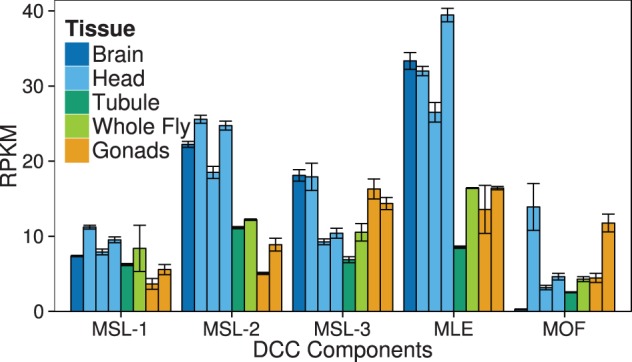
Expression level of DCC components in RNA-seq data sets. Expression level was measured in terms of RPKM. The data are from data sets 1, 2, 3, 4, 7, 8, 12, and 13 (table 1). Error bars indicate the standard error of the mean. MLE and MSL-2 are important for initial recognition of DCC binding sites and their colocalization defines the HAS, whereas MSL-1 and MOF do not colocalize with the other DCC components and are not specific to the X chromosome (Straub et al. 2013).